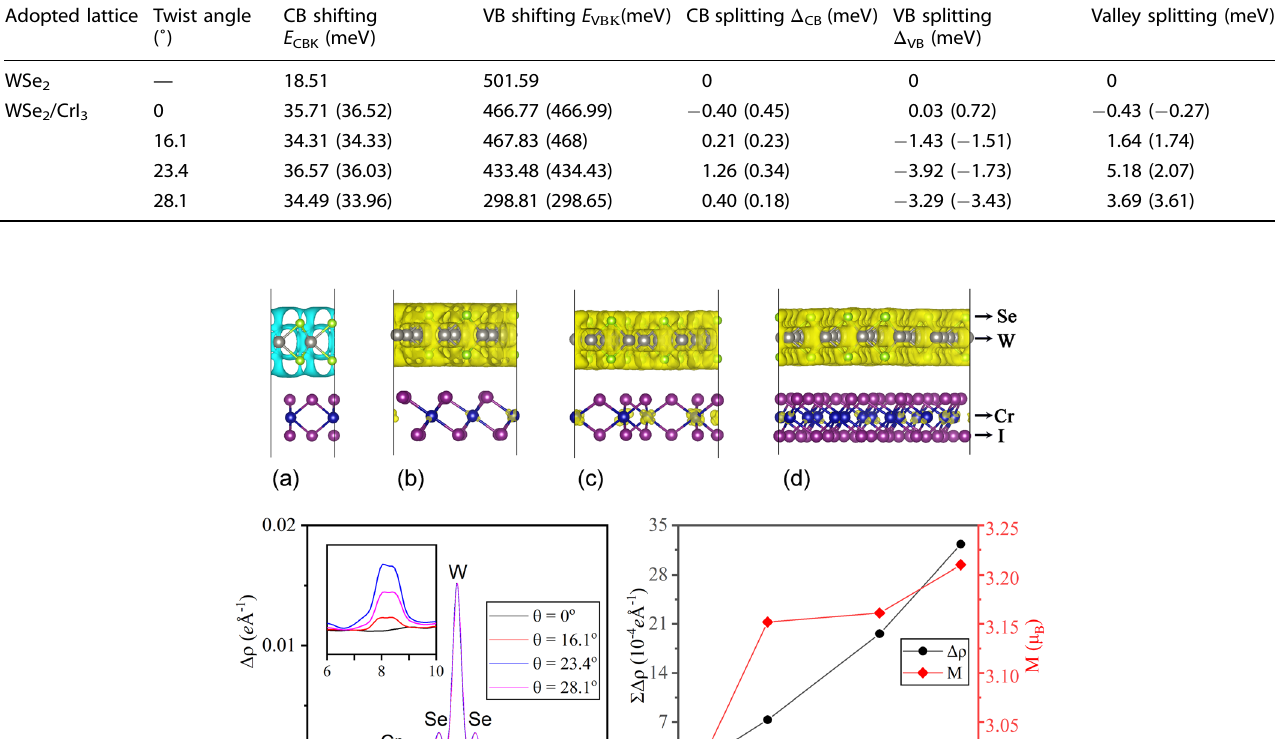
Table 2. Band splitting in WSe 2 and WSe 2 /CrI 3 heterostructures for Cr-HC and Se-HC (bracket) con fi gurations with WSe 2 lattice constant. Adopted lattice Twist angle ( ˚